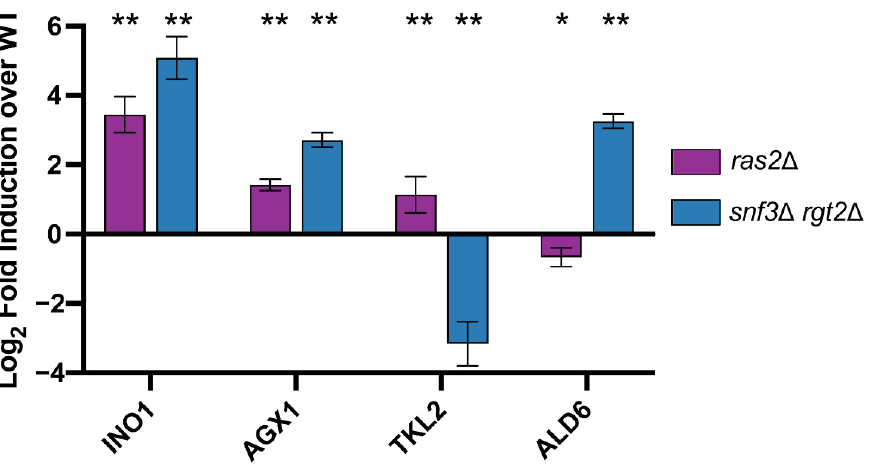
Figure 10. qPCR analysis. Bar plots of qPCR data for INO1 , AGX1 , TKL2 , and ALD6 for ras2 ∆ (purple) and snf3 ∆ rgt2 ∆ (blue). The X-axis shows target genes; Y-axis shows log2 fold induction relative to wildtype. Error bars represent standard error of mean and significance marks are as follows: p < 0.01(**), p < 0.05(*) as determined via Mann–Whitney U test and adjusted for multiple comparisons with the Benjamini–Hochberg procedure (see Methods).